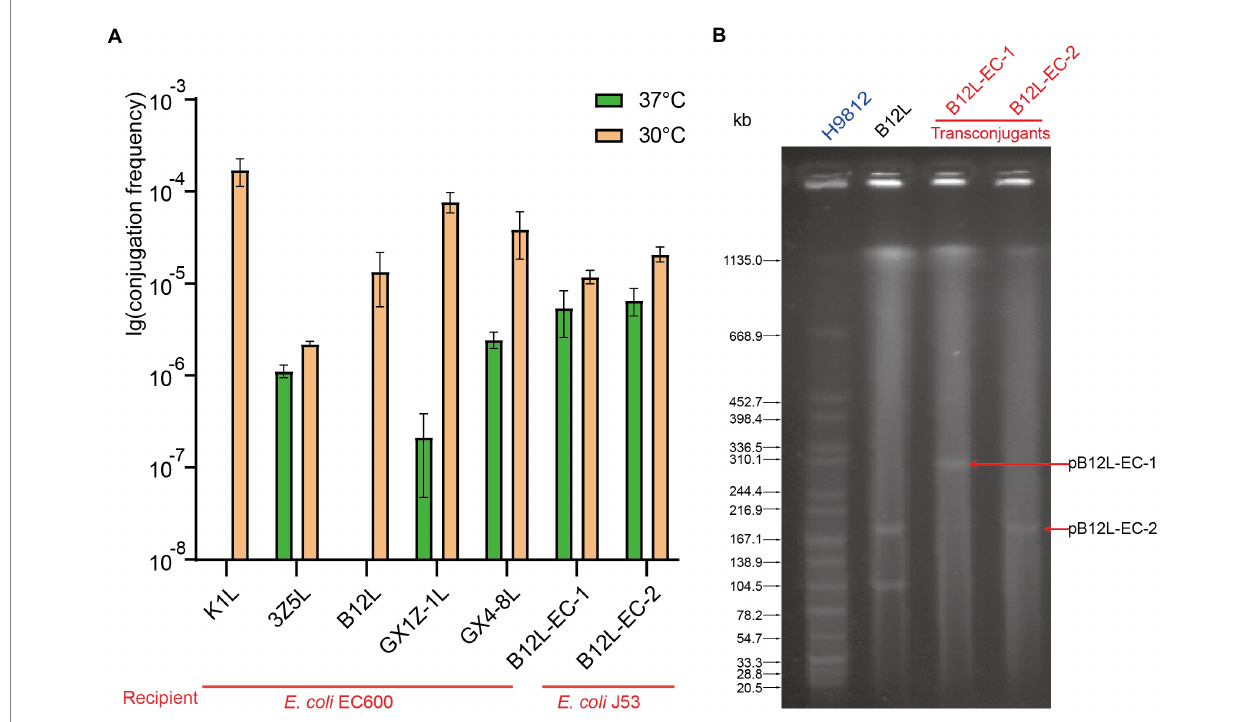
FIGURE 4 The conjugation transfer frequency of different bacteria and the plasmid profiles of fusion plasmid. (A) The conjugation transfer frequency of five tet (X4) positive strains and the transconjugants of B12L. (B) The S1-PFGE of the donor strain B12L and two types transconjugants (B12L-EC-1 and B12L-